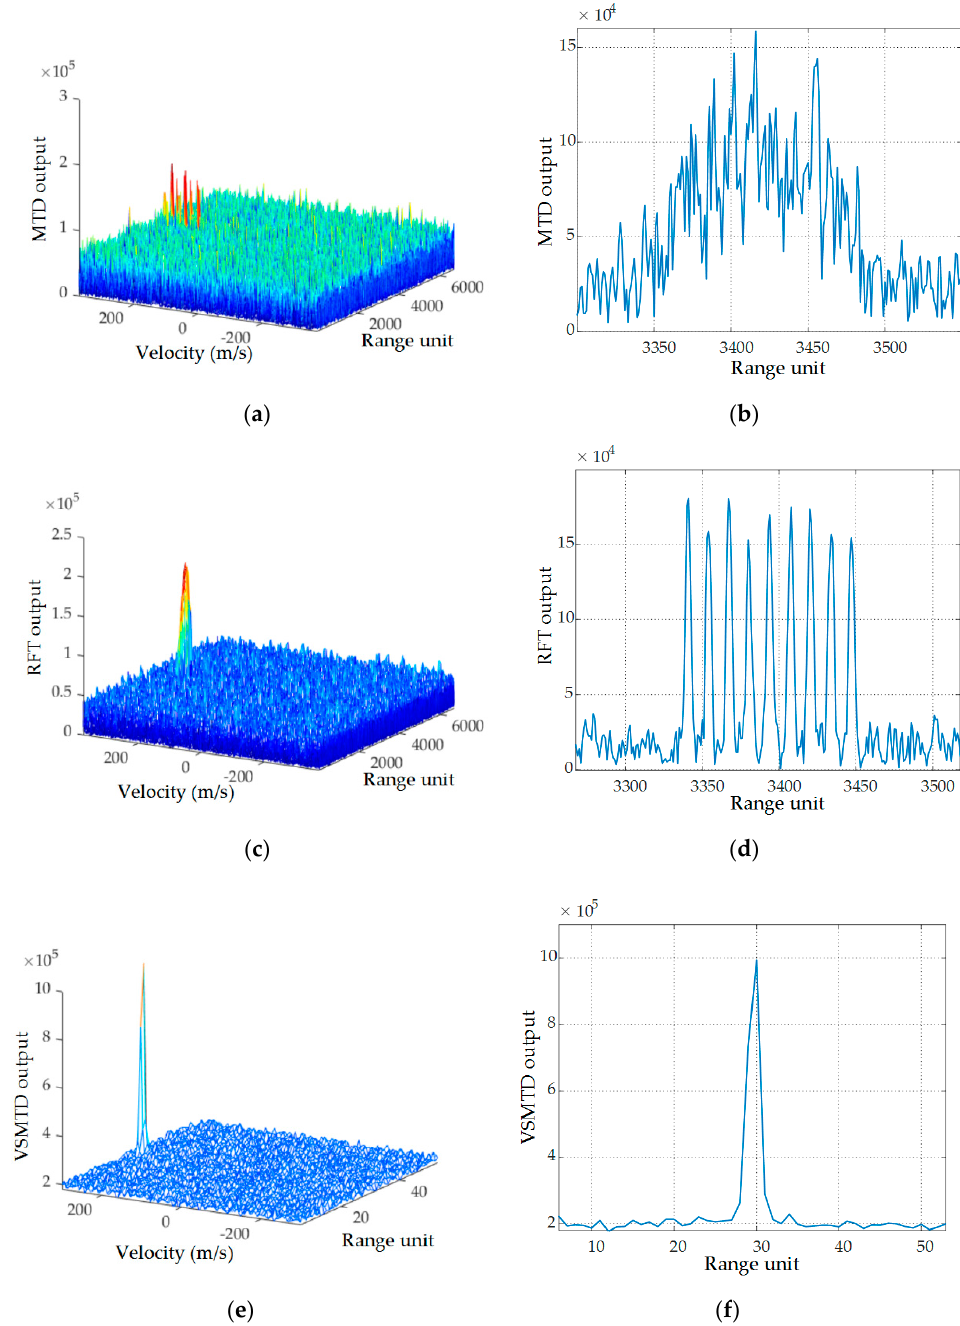
Figure 17. ( a ) MTD result with SNR = 5 dB; ( b ) Range profile of MTD result; ( c ) RFT result with SNR = 5 dB; ( d ) Range profile of RFT result; ( e ) VSMTD result with SNR = 5 dB; and ( f ) Range profile of VSMTD result.